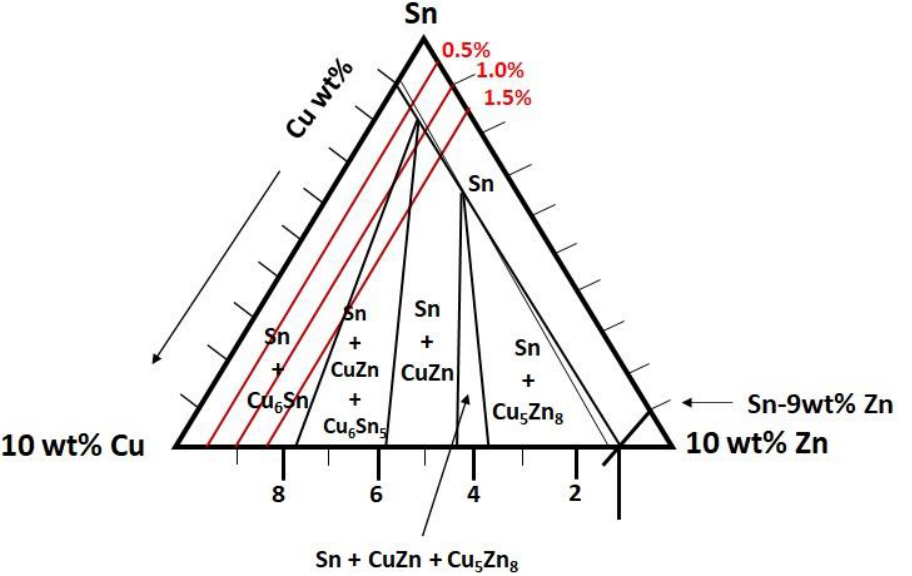
Figure 1. Ternary phase diagram of Sn-Cu-Zn